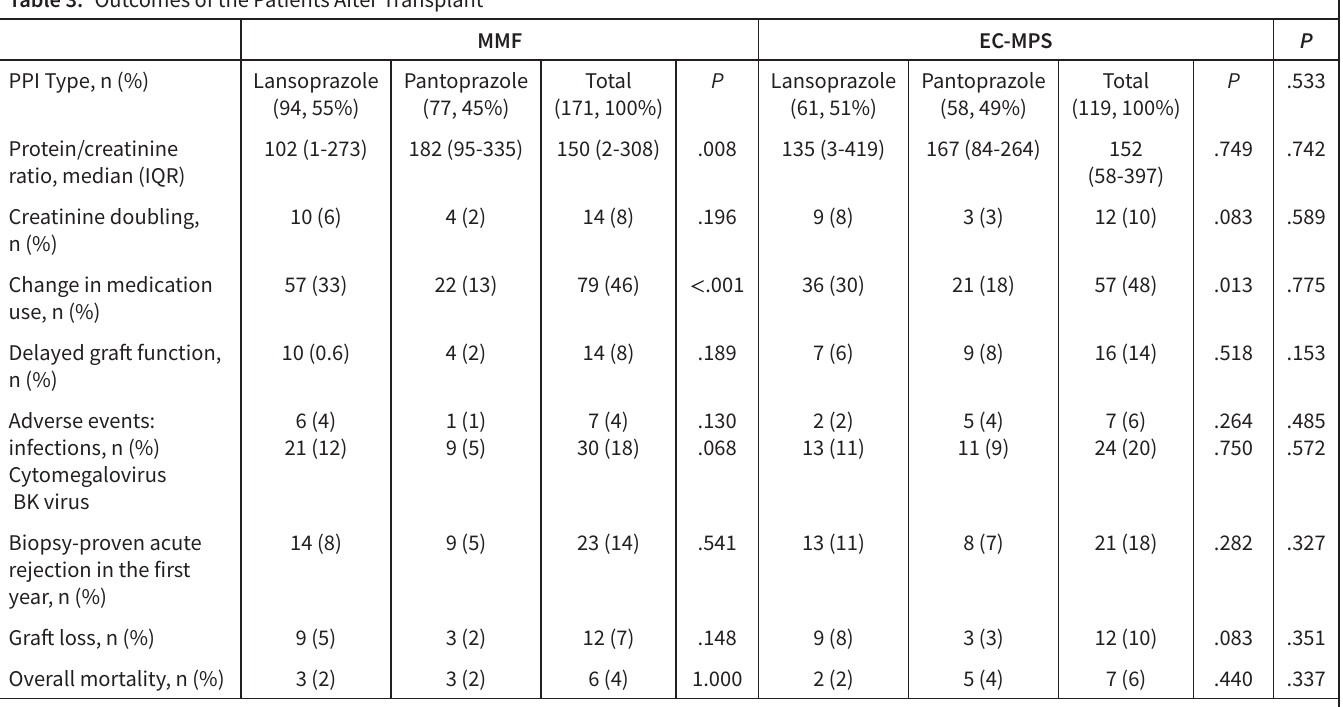
Table 3. Outcomes of the Patients After